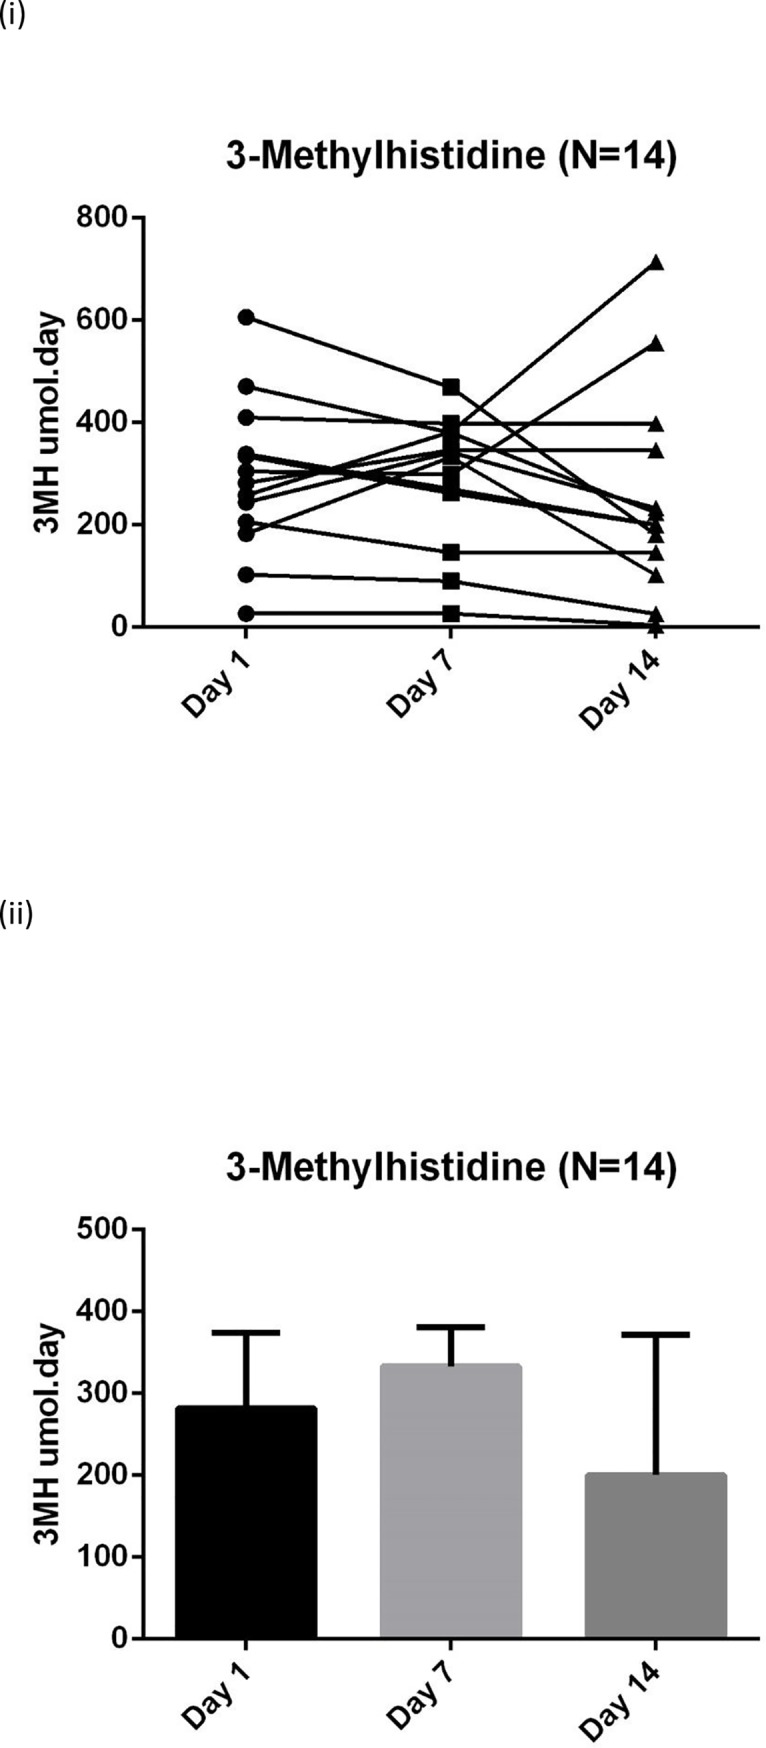
Serial 3MH (N = 14) measurements in long stay patients: (i) Plots to explore individual variability (ii) Box plots reported with median and IQR.3-MH: 3-methylhistidine. Medians and IQR are reported in the S1 Table (a), not on this figure due to wide variance.